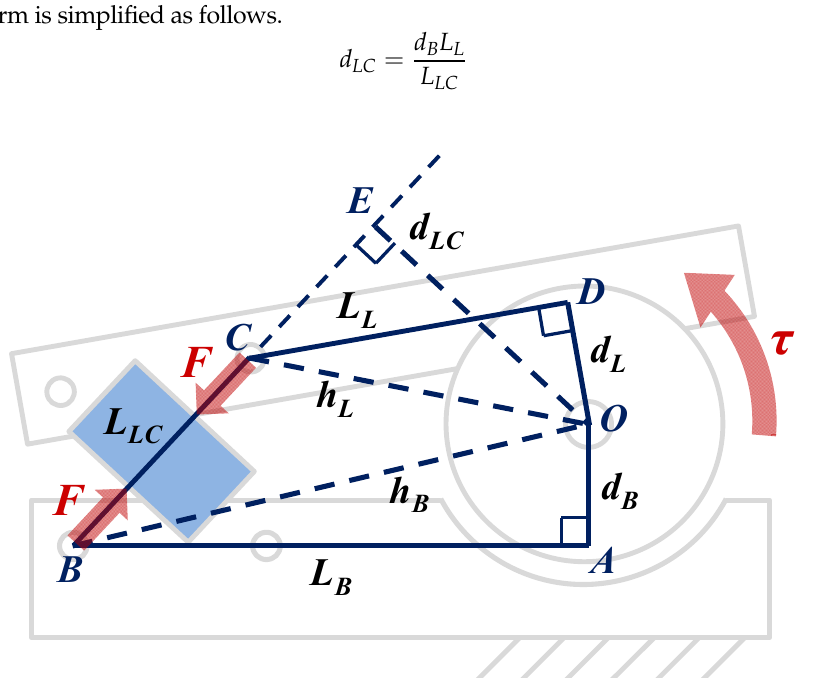
Figure 4. Schematic of the oblique load cell setup for higher sensitivity. The length of the line segment OE is defined as the moment arm d LC for the force applied by the load cell.